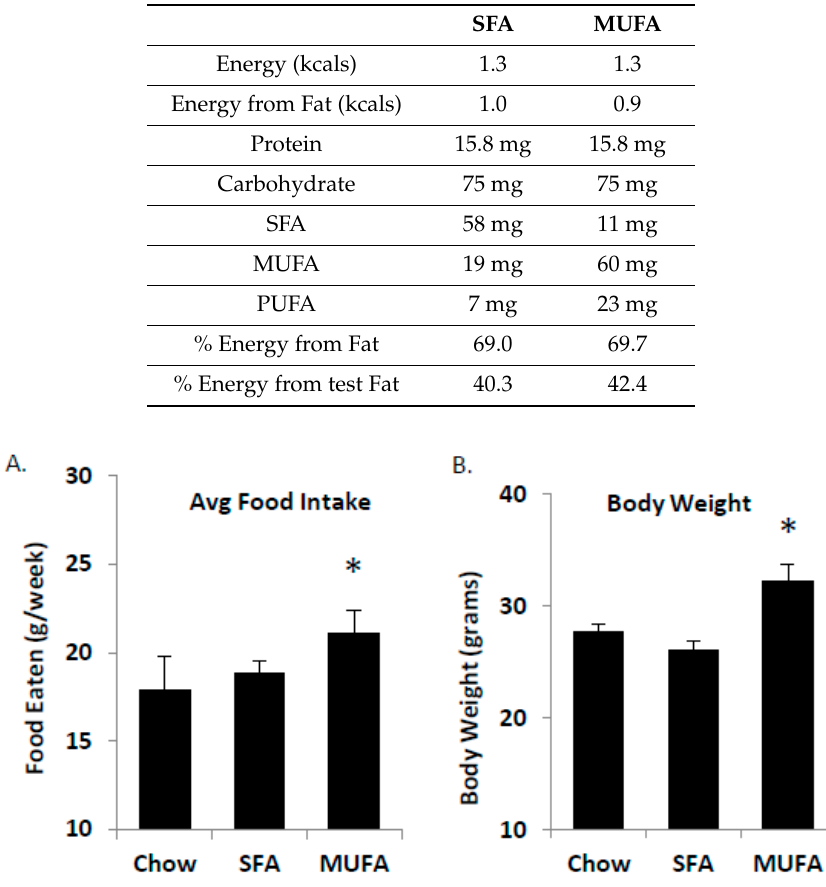
Figure 6. Food intake and body weight changes. Male C57Bl / 6 mice (age 8 weeks) were fed ad libitum either Chow, SFA-, or MUFA-enriched diets for 4 weeks. Animals on MUFA-rich diets had the greatest food intake ( A ) and displayed the greatest change in body weight over 4 weeks ( B ). Data are represented as mean ± SEM; n = 8 mice/group; * p < 0.05.